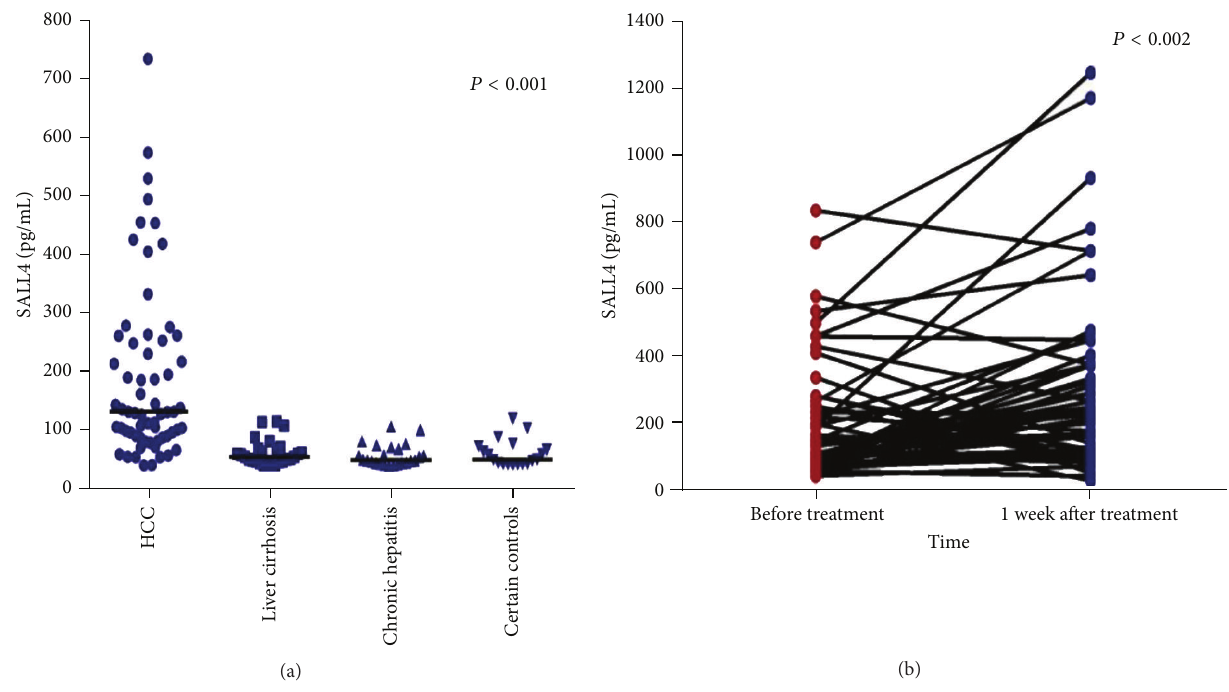
Figure 2: (a) The serum SALL4 levels in HCC and three controls. The concentration of serum SALL4 in HCC was much higher than that in controls ( 𝑃 < 0.001 ). The three control groups had no significant differences. (b) The comparison of serum SALL4 levels ( 𝑛 = 52 ) before and after treatment. The level of serum SALL4 after treatment was higher than before treatment ( 𝑃 < 0.002 ).